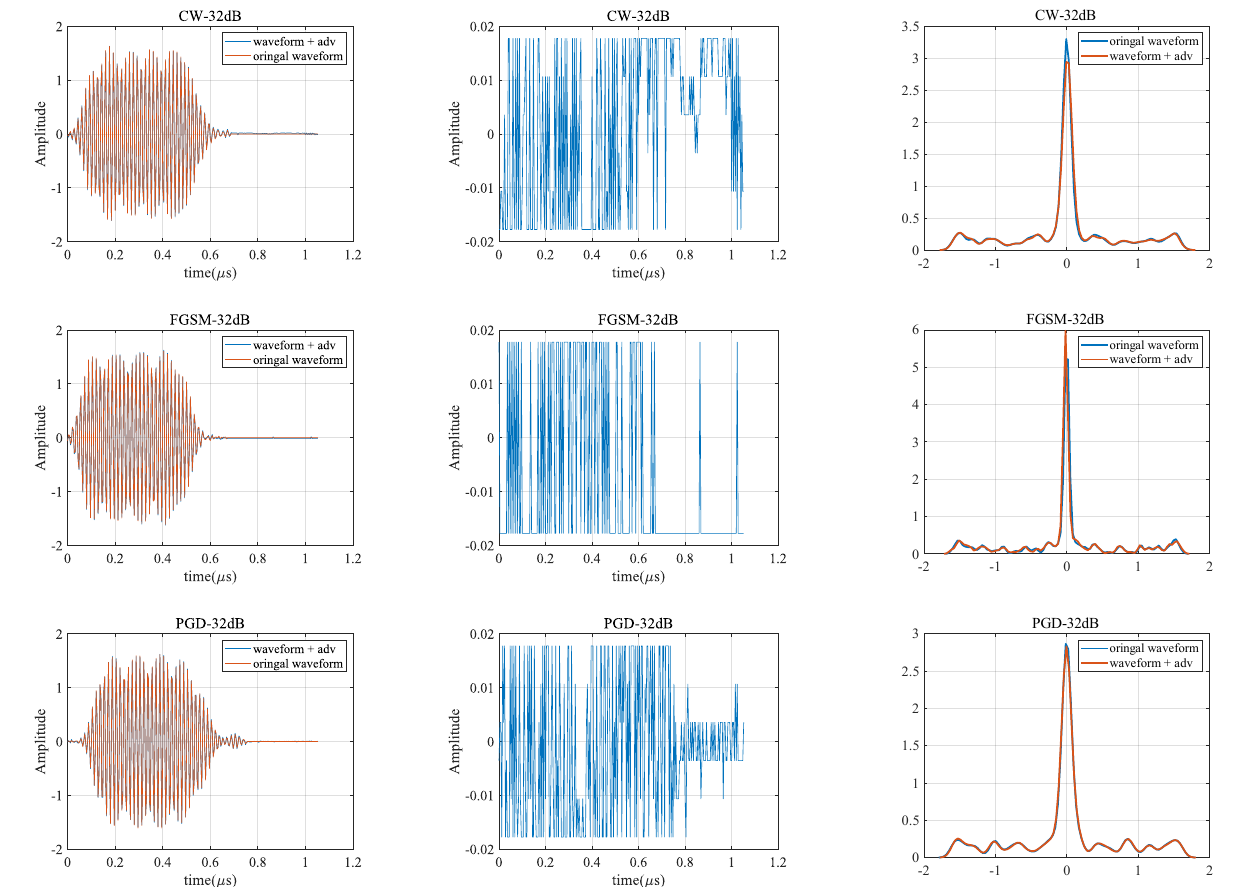
Figure 13. Waveforms of the three attack methods at PSR = − 32 dB. The original waveforms and waveforms with the added adversarial attack of the three attack methods (waveform + adv) are shown in the left column. The second column of subplots shows the waveforms of the added adversarial examples. The third column shows the probability density function (PDF) of the